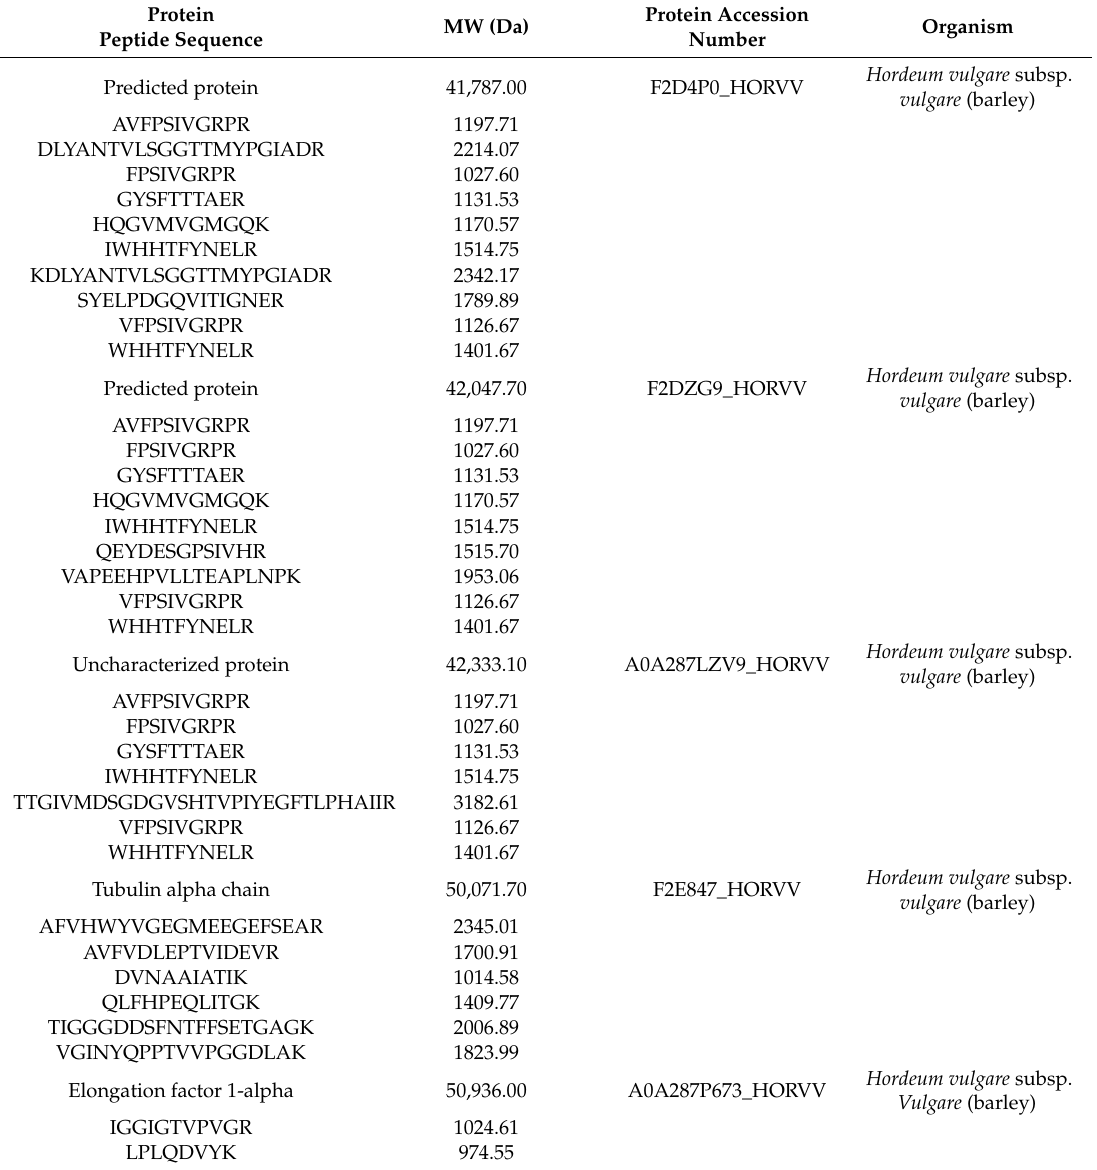
Table 2. Identified peptides and parent proteins in F1 from in vitro digestate of yellow C09052 hairless canary seed